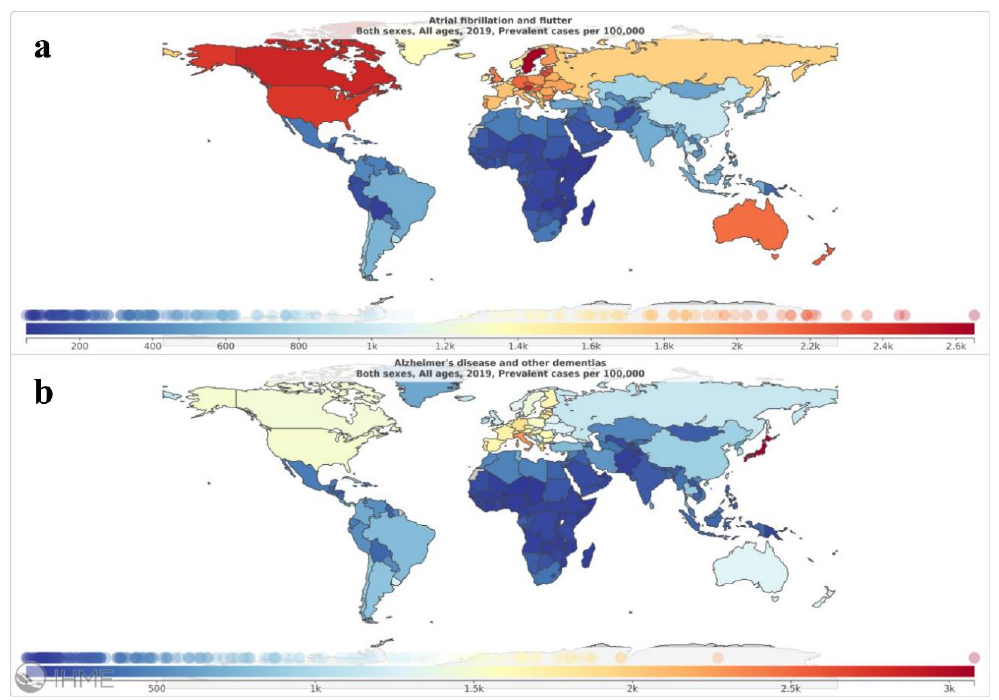
Figure 2. Global maps depicting crude prevalence rate of the investigated conditions in 2019: panel ( a ), atrial fibrillation and atrial flutter; panel ( b ) , Alzheimer’s disease and other forms of dementia. Source: https://vizhub.healthdata.org/epi/, (accessed on 12 November 2021). In 2019, AF was characterized by a incidence rate of 61.01 per 100,000 individuals (age-standardized estimate: 57.09 per 100,000 individuals), while prevalence rate settled at 771.51 per 100,000 individuals (age-standardized estimate: 743.47 per 100,000 individ- uals); AF-specific mortality rate was 4.08 per 100,000 individuals, accounting for 0.56% of the total mortality burden worldwide, while the rate of DALYs lost for AF amounted to 108.48 years per 100,000 individuals (0.33% of the total DALYs burden). Dementia was characterized by a slightly higher incidence rate (93.52 per 100,000 individuals; age-stand- ardized estimate: 94.99 per 100,000 individuals) and a similar prevalence rate (667.20 per 100,000 individuals; age-standardized estimate: 682.48 per 100,000 individuals) compared to AF, while morbidity metrics were evidently higher for dementia (mortality rate: 20.89 per 100,000 individuals, 2.87% of the total mortality burden; rate of DALYs lost due to dementia: 326.68 years per 100,000 individuals, 1% of the total DALYs burden). Comparing data from low and high SDI countries, evident differences are appreci- ated. In fact, crude estimates of all of the investigated metrics are higher in high SDI coun- tries both for AF and dementia. For example, crude AF incidence rate is nearly seven times higher in high SDI countries compared to low SDI countries, while dementia is character- ized by a ninefold increase in crude incidence rate. Similarly, the crude mortality and morbidity burden (mortality rate and rate of DALYs lost) of both conditions is 8 – 10 times higher in high SDI countries. Looking at age-standardized metrics we found that (albeit by a reduced magnitude) the estimates are still higher in high SDI countries if compared to lower ones.